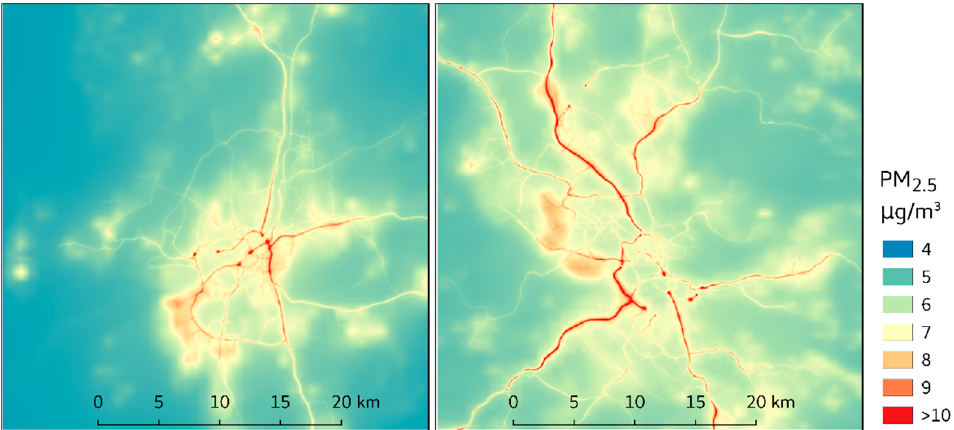
Figure 2. Yearly average concentrations of PM 2.5 during the baseline year 2011 in Gothenburg (left) and Stockholm (right) [14]. Table 1. Population-weighted concentrations for the baseline year 2011 and population aged > 30 years [14].